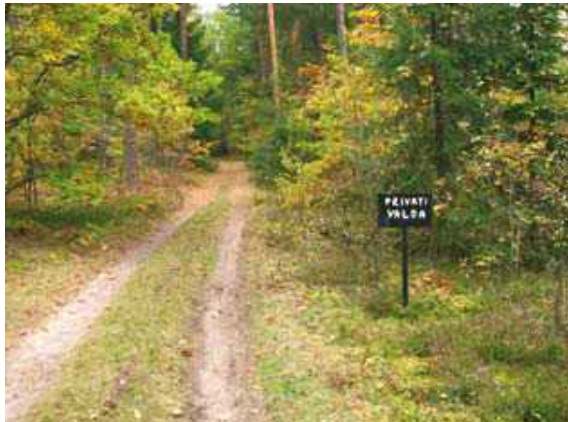
Fig. 1. Mis le a ding sign ‘’Pri va te“ in the mid dle of a fo rest – com mon sight in Lit hu a nia no wa da ys. (Pho to by M. ka va- liaus